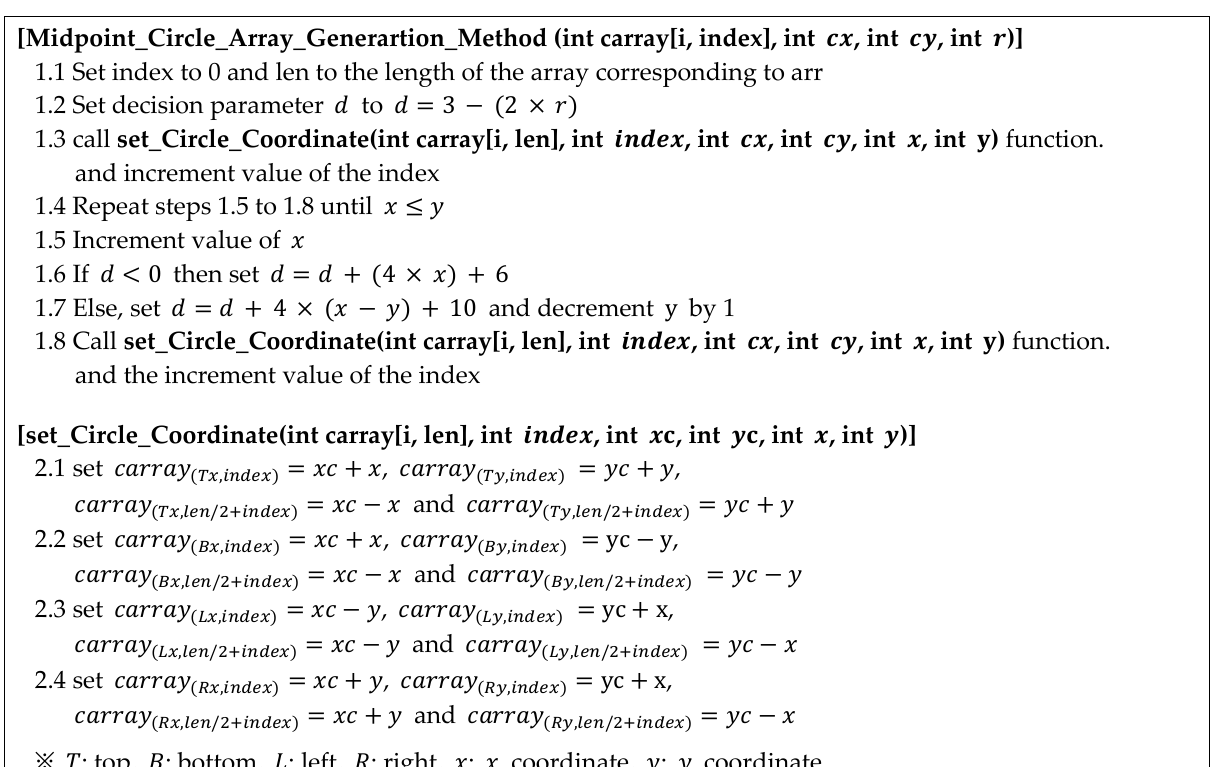
Figure 9. Generation of a circular coordinate array.